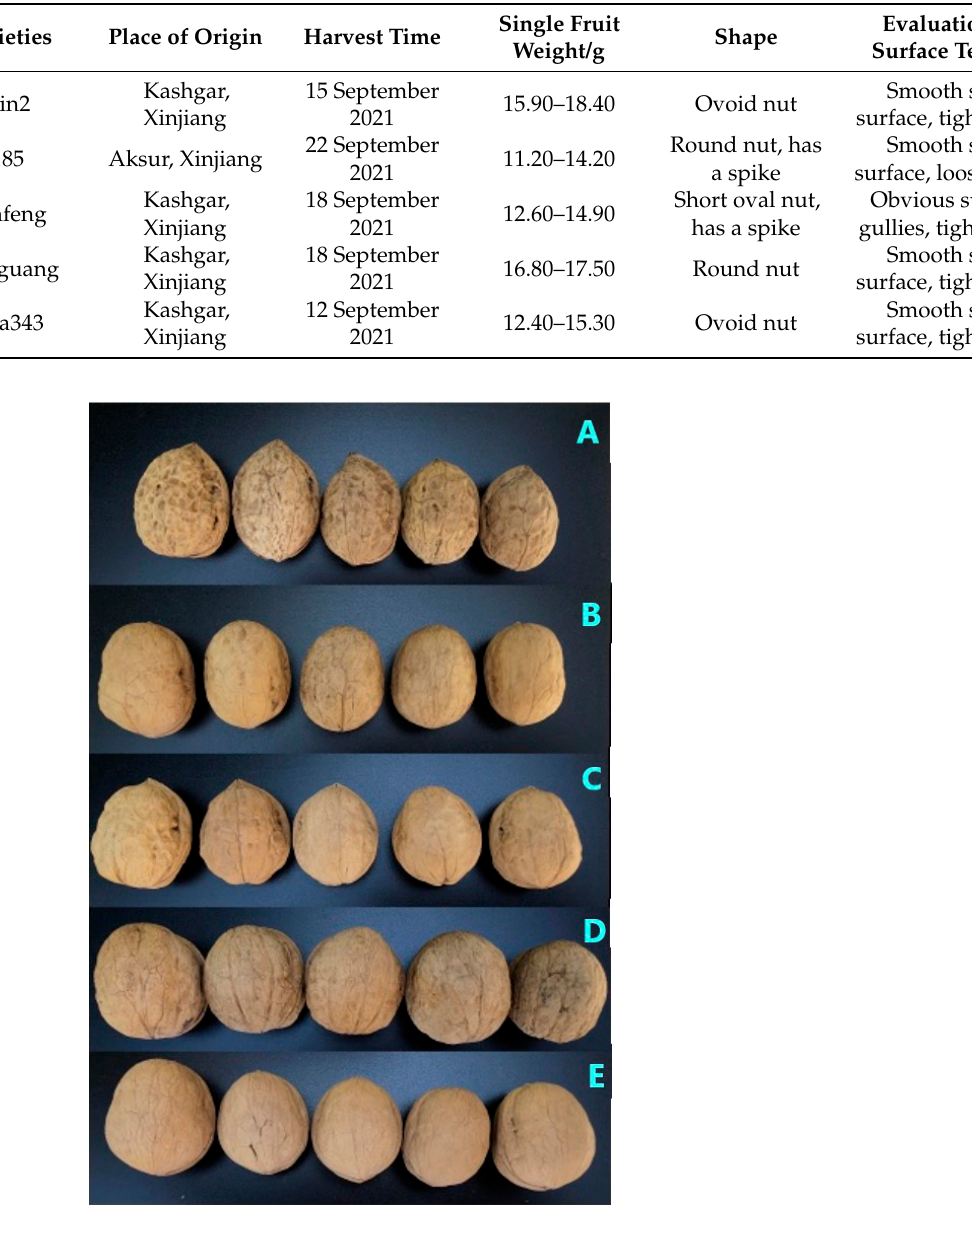
Table 3. Information of walnut from five varieties.